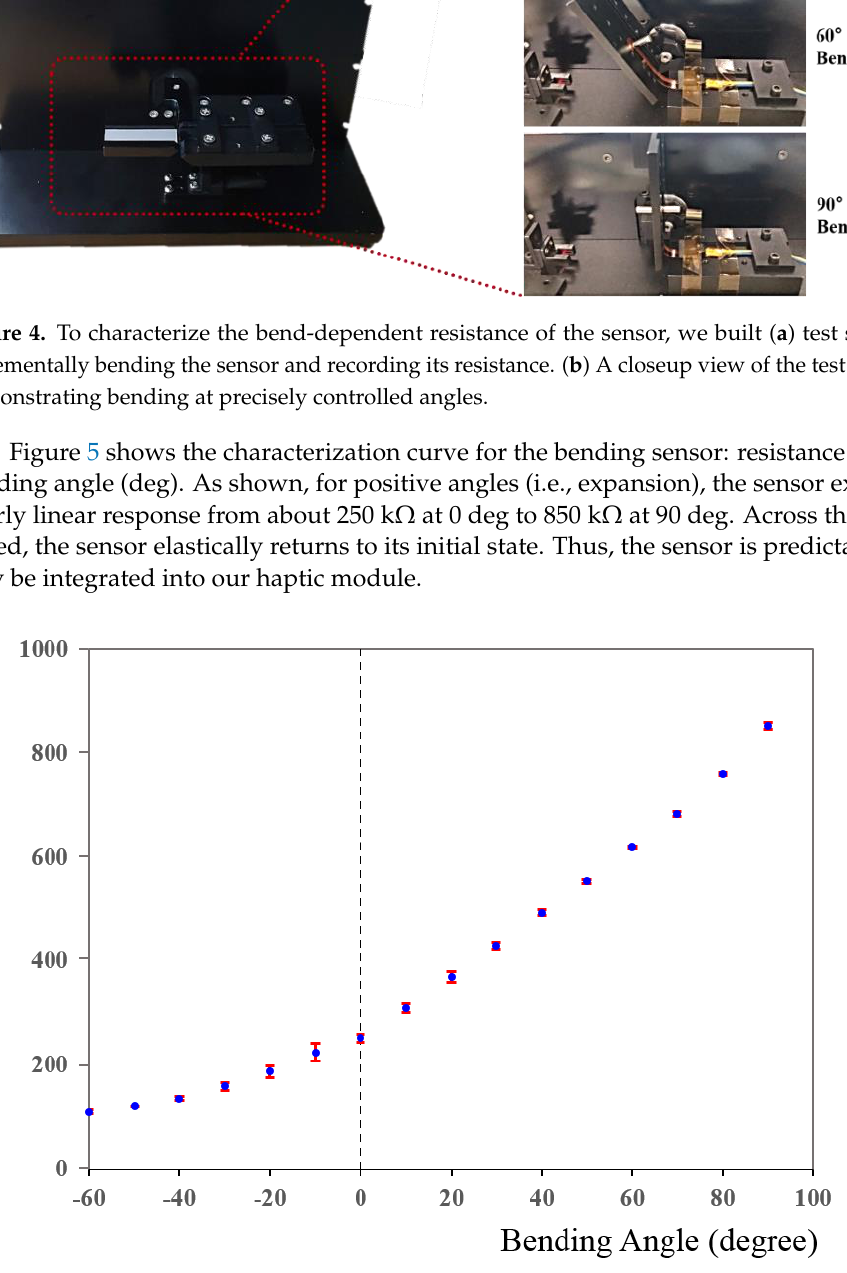
Figure 5. Results of the bending characterization indicate near-linear performance in the bend di- rection.